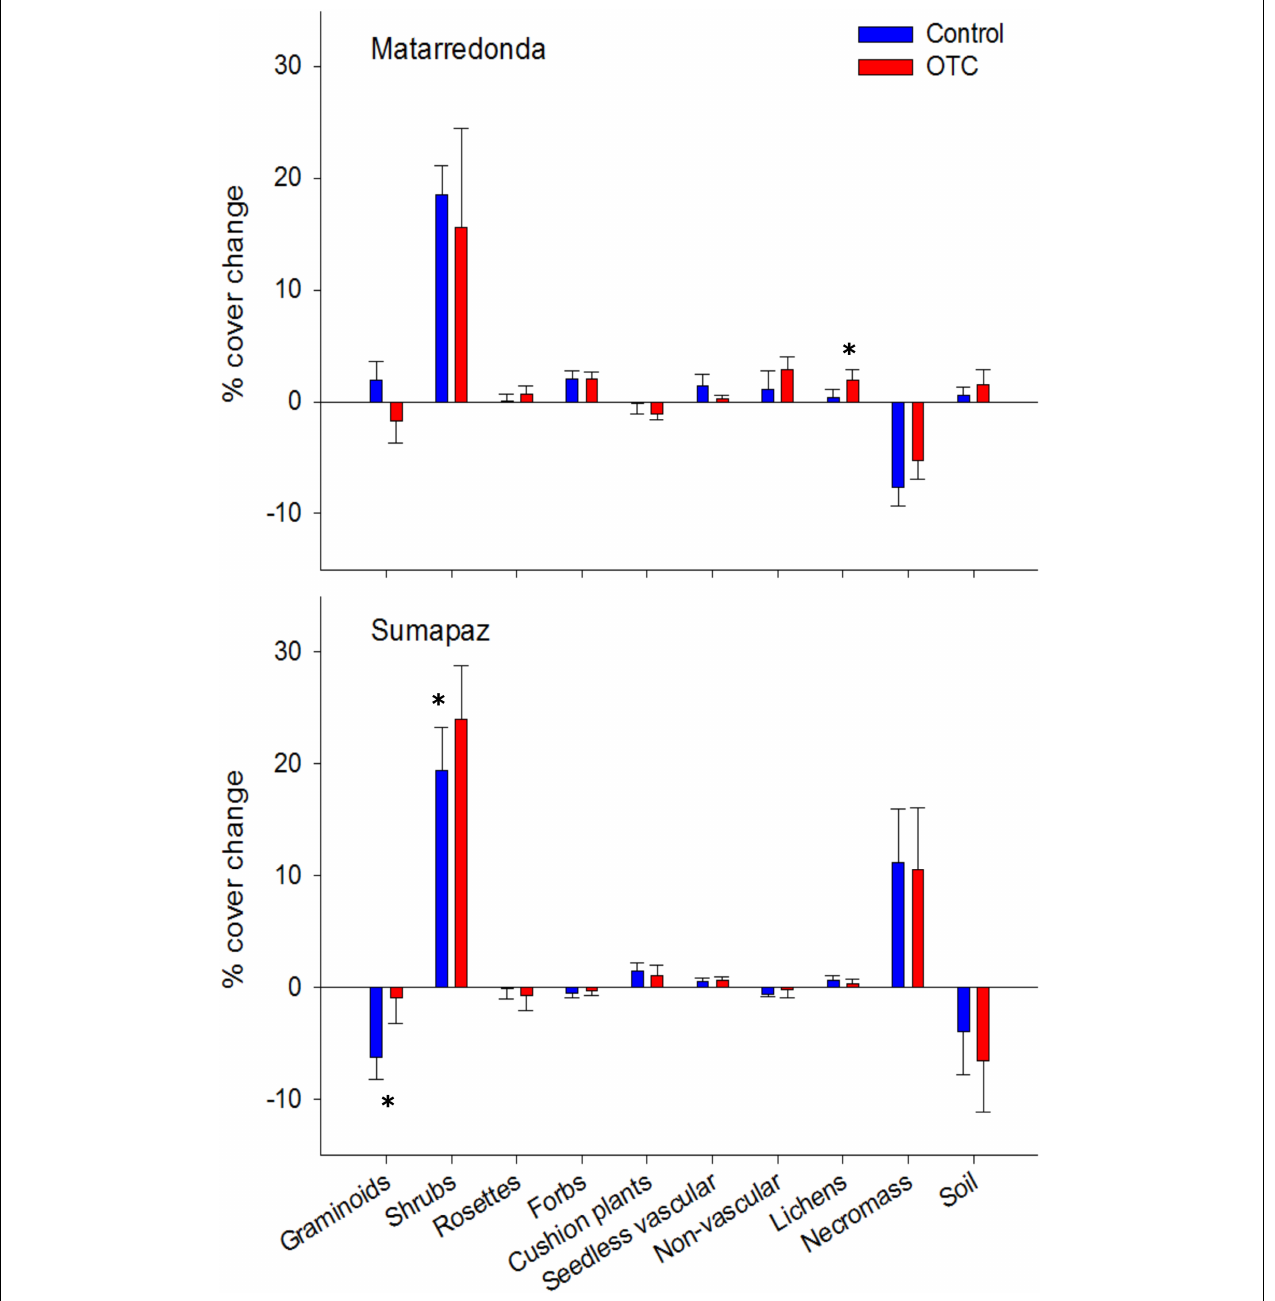
FIGURE 7 | Changes in vegetation cover of the main growth forms in the páramo and of the bare soil and necromass cover after 3 years of warming. We present the percentage cover change that has occurred during 3 years of warming. Positive values denote an increase in cover since the start of the experiment and negative values a reduction in cover. Errors bars represent the standard error. Asterisk denote statistically significant differences between OTC and control plots at P <